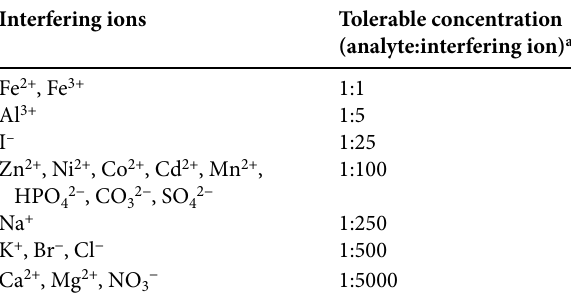
Table 2. Study of interfering ions.